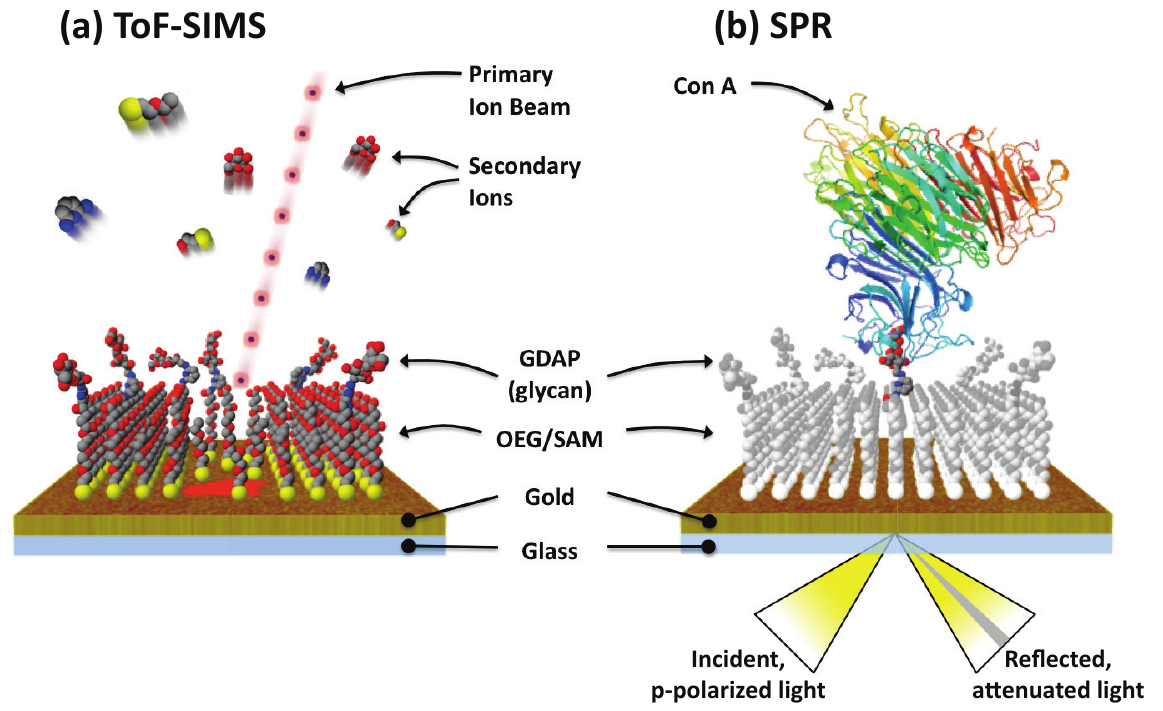
Figure 1. Analysis of glycan-functionalized array surfaces. (a) ToF-SIMS analysis generates a mass spectrum of the outermost 1.5 – 2.0 nm of a surface by bombarding it with a primary ion beam. In the case of carbohydrate-modified self-assembled monolayers on gold, the SIMS process generates ions that can be traced back to the underlying surfaces, the immobilization chemistries, and the glycans, generating a molecular image of the surface. (b) In SPR, real-time refractive index changes at the surface ( i.e. , due to protein-carbohydrate binding, as shown) can be quantified and used to determine binding kinetics. This illustration shows the binding of the plant lectin Concanavalin A (Con A) to a carbohydrate-modified self-assembled monolayer (SAM).